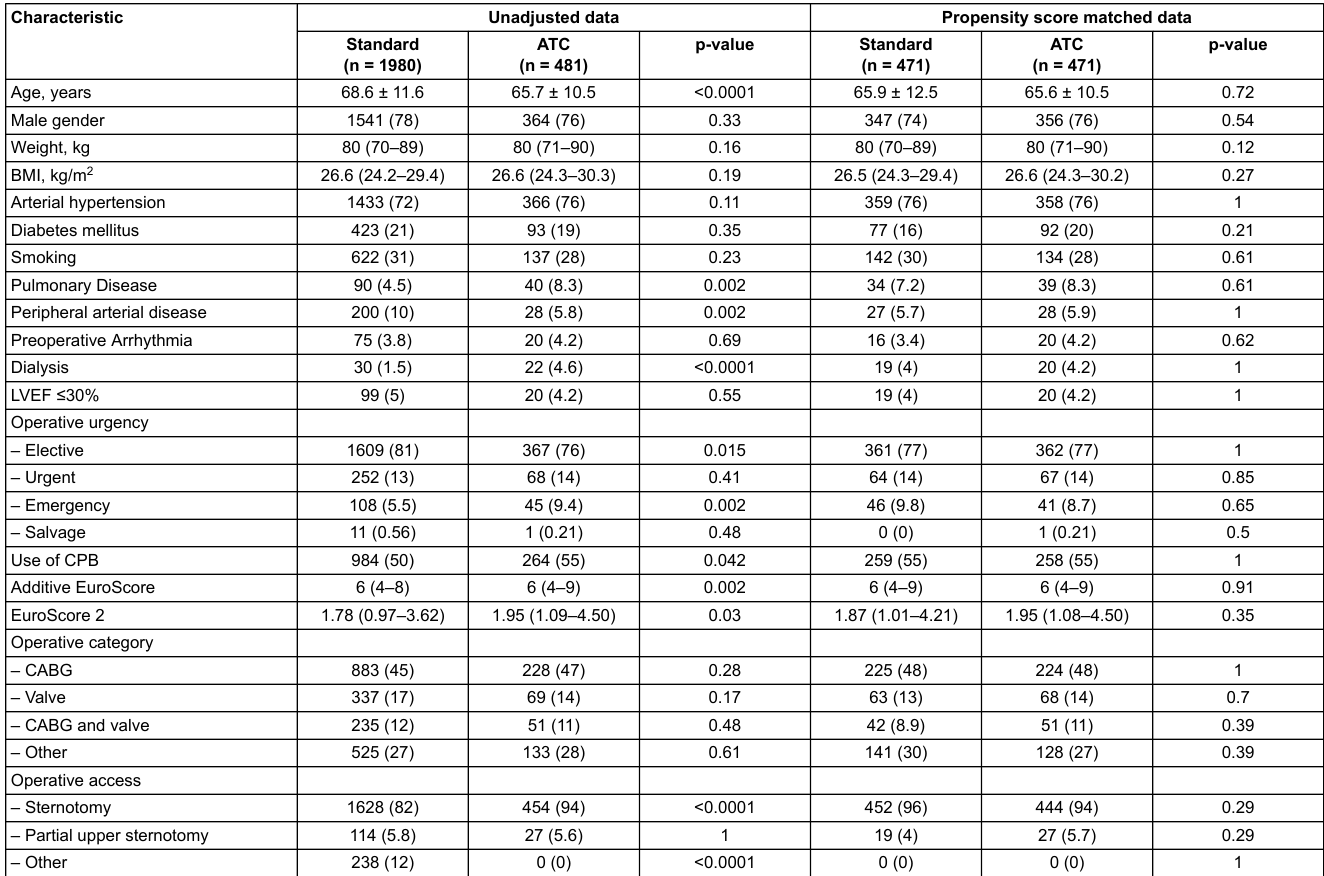
Table 1: Baseline characteristics.